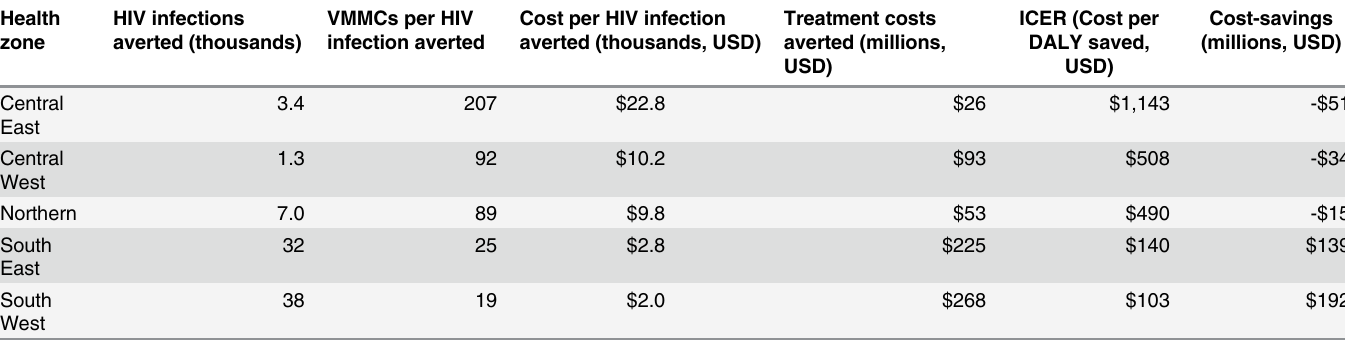
Table 2. Impact and cost of scaling-up VMMC coverage to 60% among males ages 10 – 34, by health zone, 2015 – 2029. Health HIV infections zone averted (thousands)